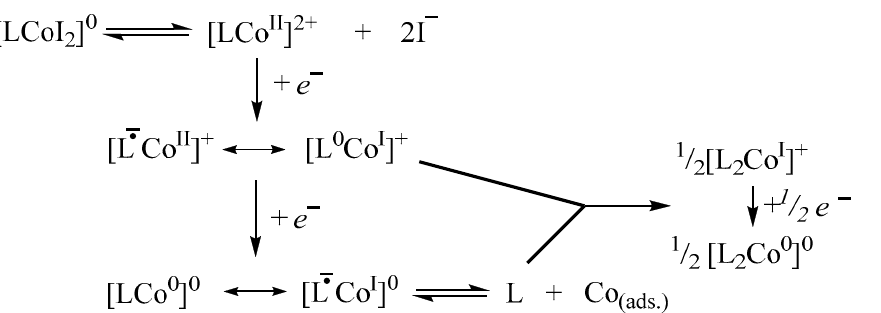
Figure 6. ( a ) Voltammogram of I (2.1 mM in 0.05 M n -Bu 4 NBF 4 in MeCN, 50 mV/s, Pt); ( b ) semi- integral transformation of the cathode part of the voltammogram shown in Figure 6a.